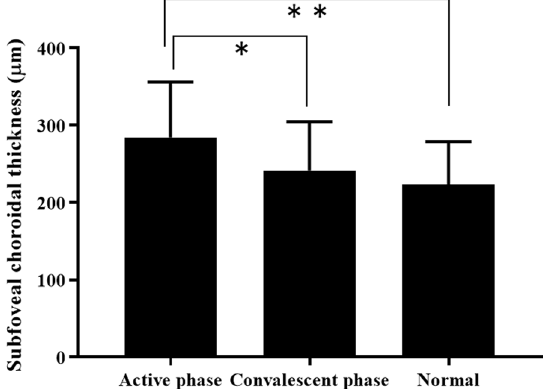
Figure 1. Subfoveal choroidal thickness (SCT) in the active and convalescent phases of Behçet’s uveitis and in normal eyes. SCT is significantly higher in the active phase than in the convalescent phase or in control eyes. Data are presented as mean ± SD. Statistical analyses were performed using the Wilcoxon signed-rank test (SCT in the active phase vs SCT in the convalescent phase, * p < 0.05) and the MannWhitney U test (SCT in the active phase vs SCT in the control eyes, ** p < 0.05),